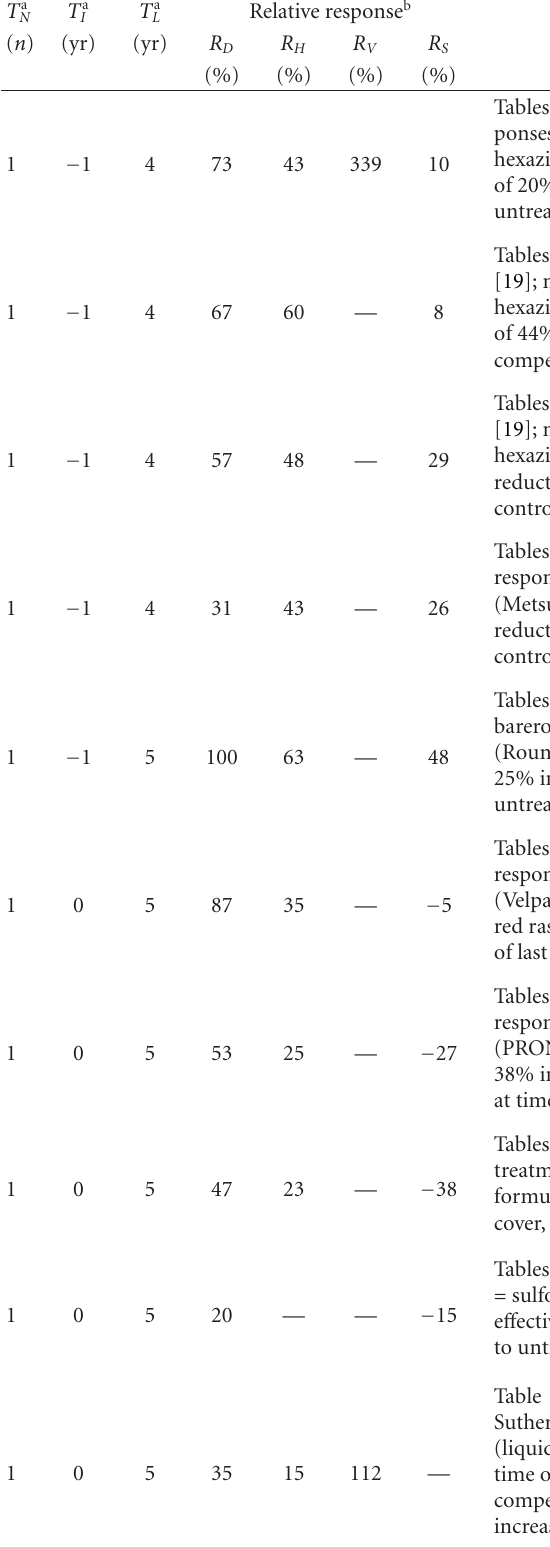
Table 1: Relative yield responses and associated experimental details ordered by number of sequential treatments ( T N ), initial year of treat- ment application relative to the year of seedling establishment ( T I (yr)); and length of the observation period relative to the year of seedling establishment ( T L